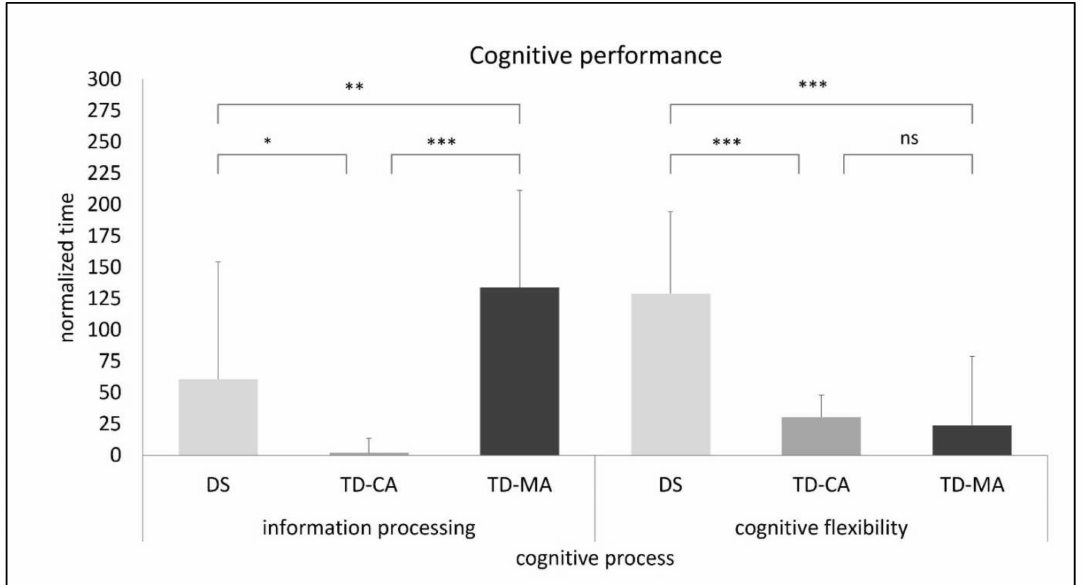
Figure 3. Performance in information processing and cognitive flexibility based on the normal- ized times in the Trail-Making Test (ns: not significant; *** p < 0.001; ** p < 0.01; * p < 0.05). Note: DS = Down Syndrome; TD-CA = Typically developing children of the same chronological age; TD-MA = Typically developing children of the same mental